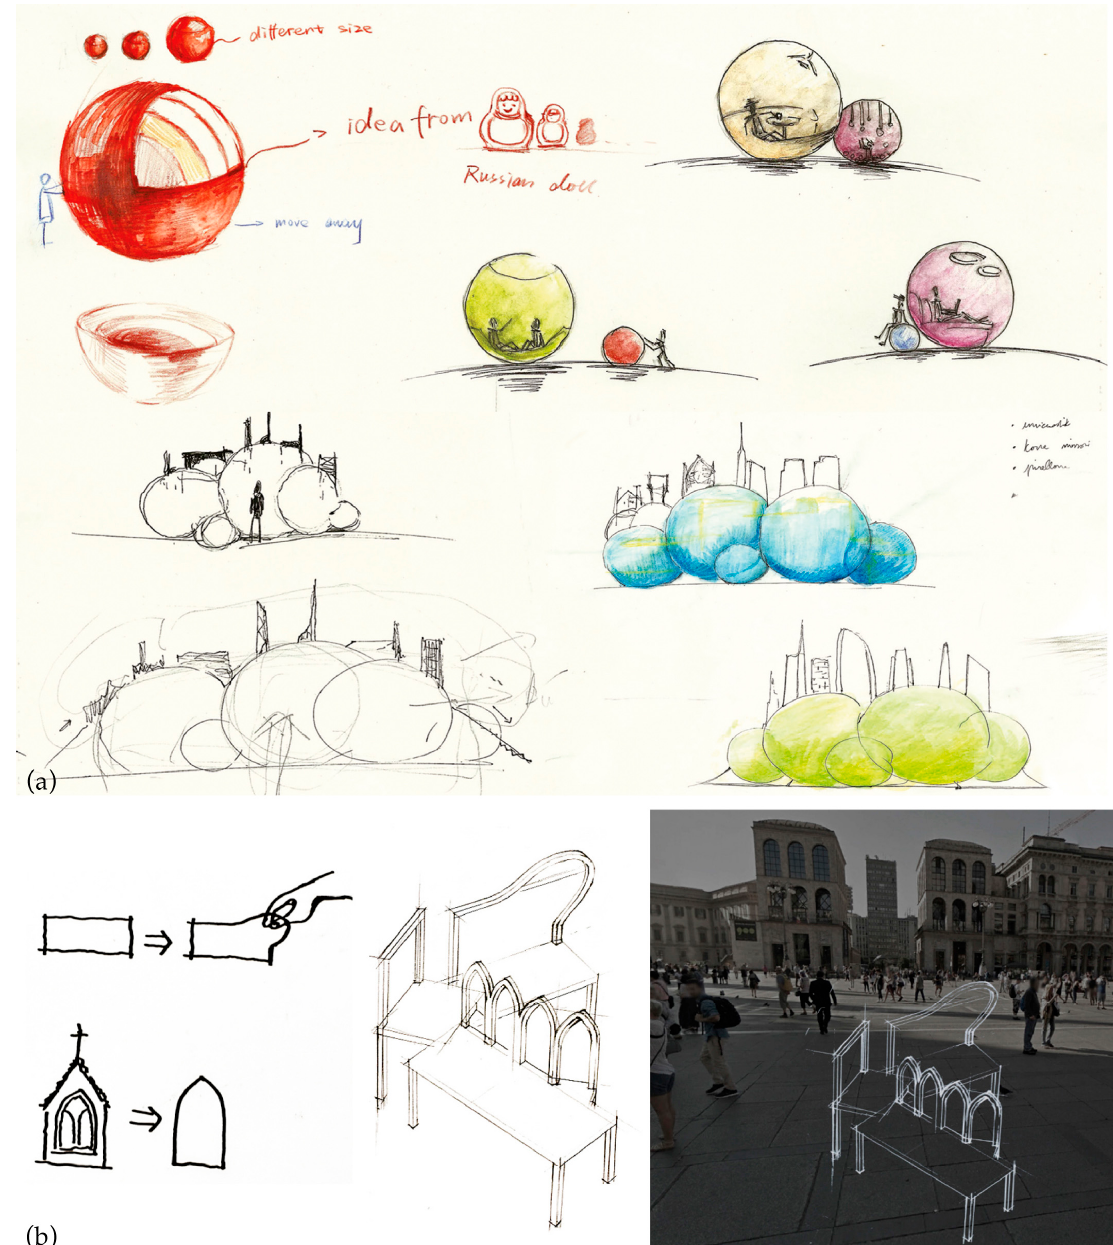
Figure 2. Same sketches realized by the students during the workshop. ( a ) The concept of the project “Milano una città a 360°”; ( b ) The shapes of windows of the Dome are the concept to realize benches to be placed in the